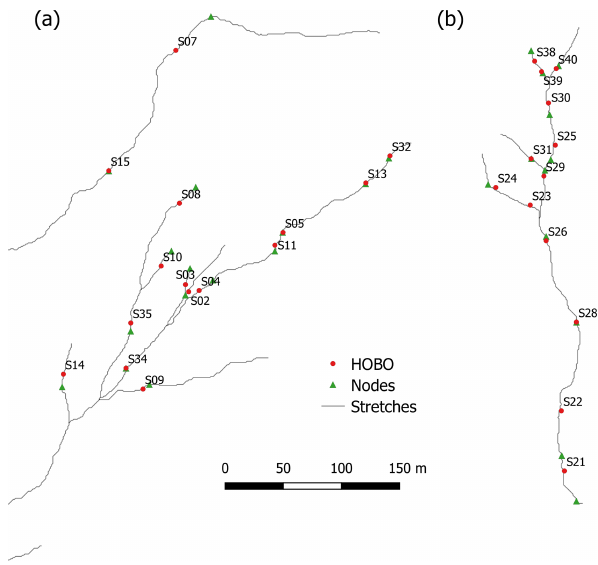
Figure A1. Nodes and corresponding sensors of the tributaries of Zone 1 (a) and Zone 2 (b)